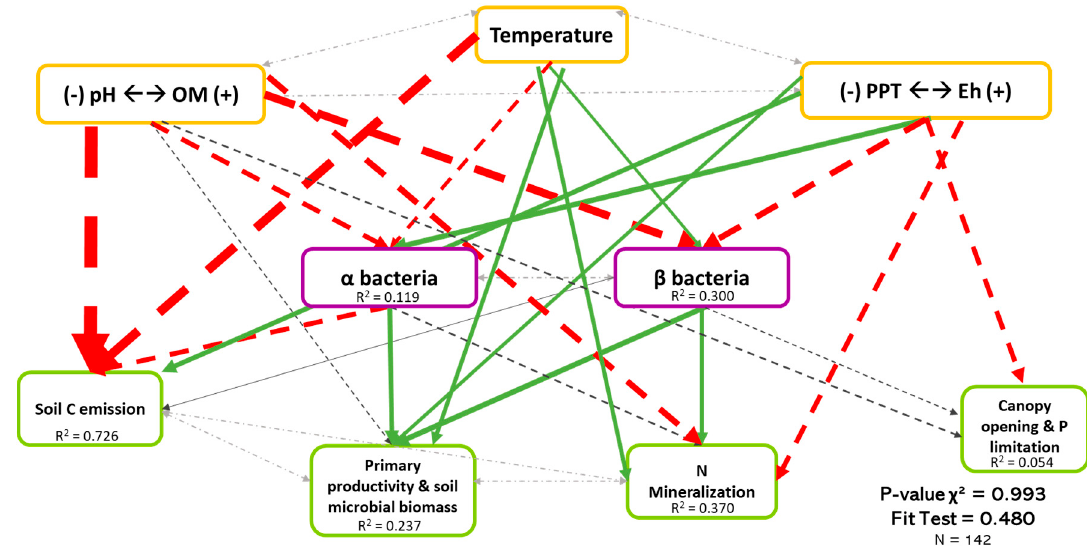
Figure 5. Causal relationships between abiotic variables, bacterial diversity, and ecosystem functioning. Structural equation model of boreal forest ecosystems in Quebec. The direction of the arrows indicates the direction of the regression existing between the variables. The solid (green) arrows represent a positive correlation, while the dotted (red) arrows represent negative correlations ( Supplementary Material Table S3.2 ). The small pale gray arrows show the covariation. The black arrows are the nonsignificant correlations at a threshold of 0.1. The thickness of these arrows informs about the strength of the correlation. The R 2 shows the proportion of variance explained for each variable and the model's P-value and fit test indicate the acceptability of the model. The strongest relationships are between organic matter (and pH) and temperature-related variables and the soil C emission, but there are also non neglectable relationships between the diversity and three ecosystem functions (F1, F2, and F3). n = 142 .